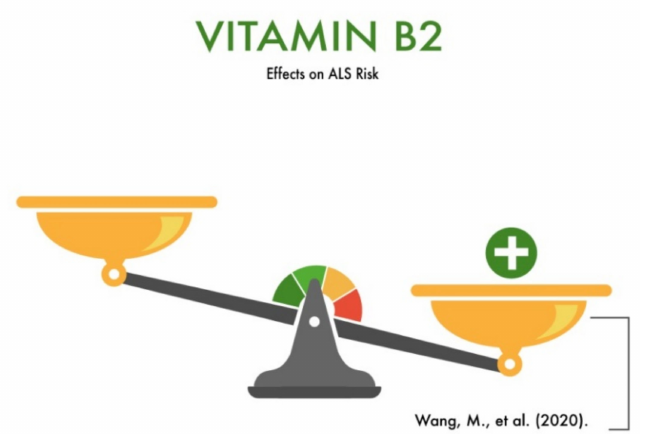
Figure 3. The effect of vitamin B2 on the risk of developing amyotrophic lateral sclerosis